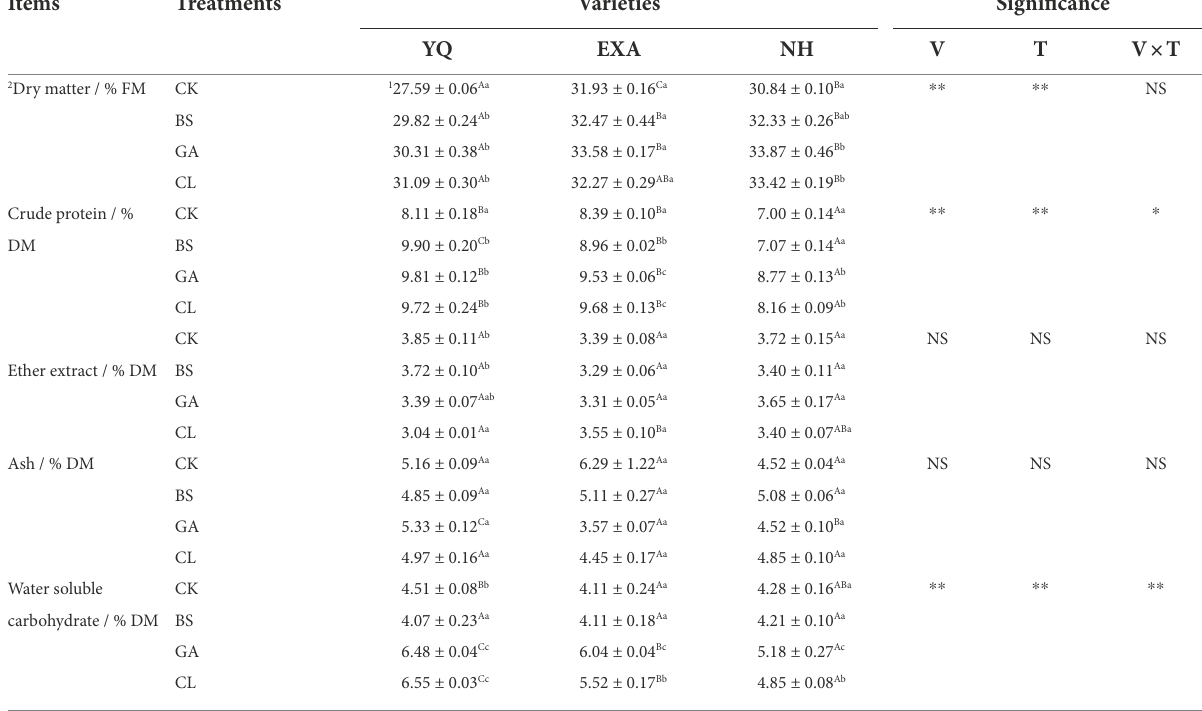
TABLE 2 Effects of varieties and additives on the chemical compositions of whole-plant corn silage (±SD, n = 3). Items Treatments